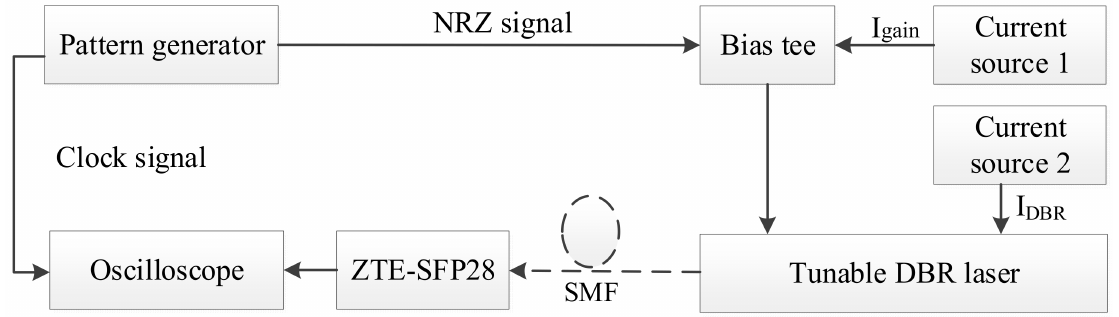
Figure 5. Experimental setup used to measure the 25 Gb/s transmission characteristics of the packaged DBR laser. NRZ: non-return-to-zero; SMF: single mode fiber; DBR: distributed Bragg reflector.